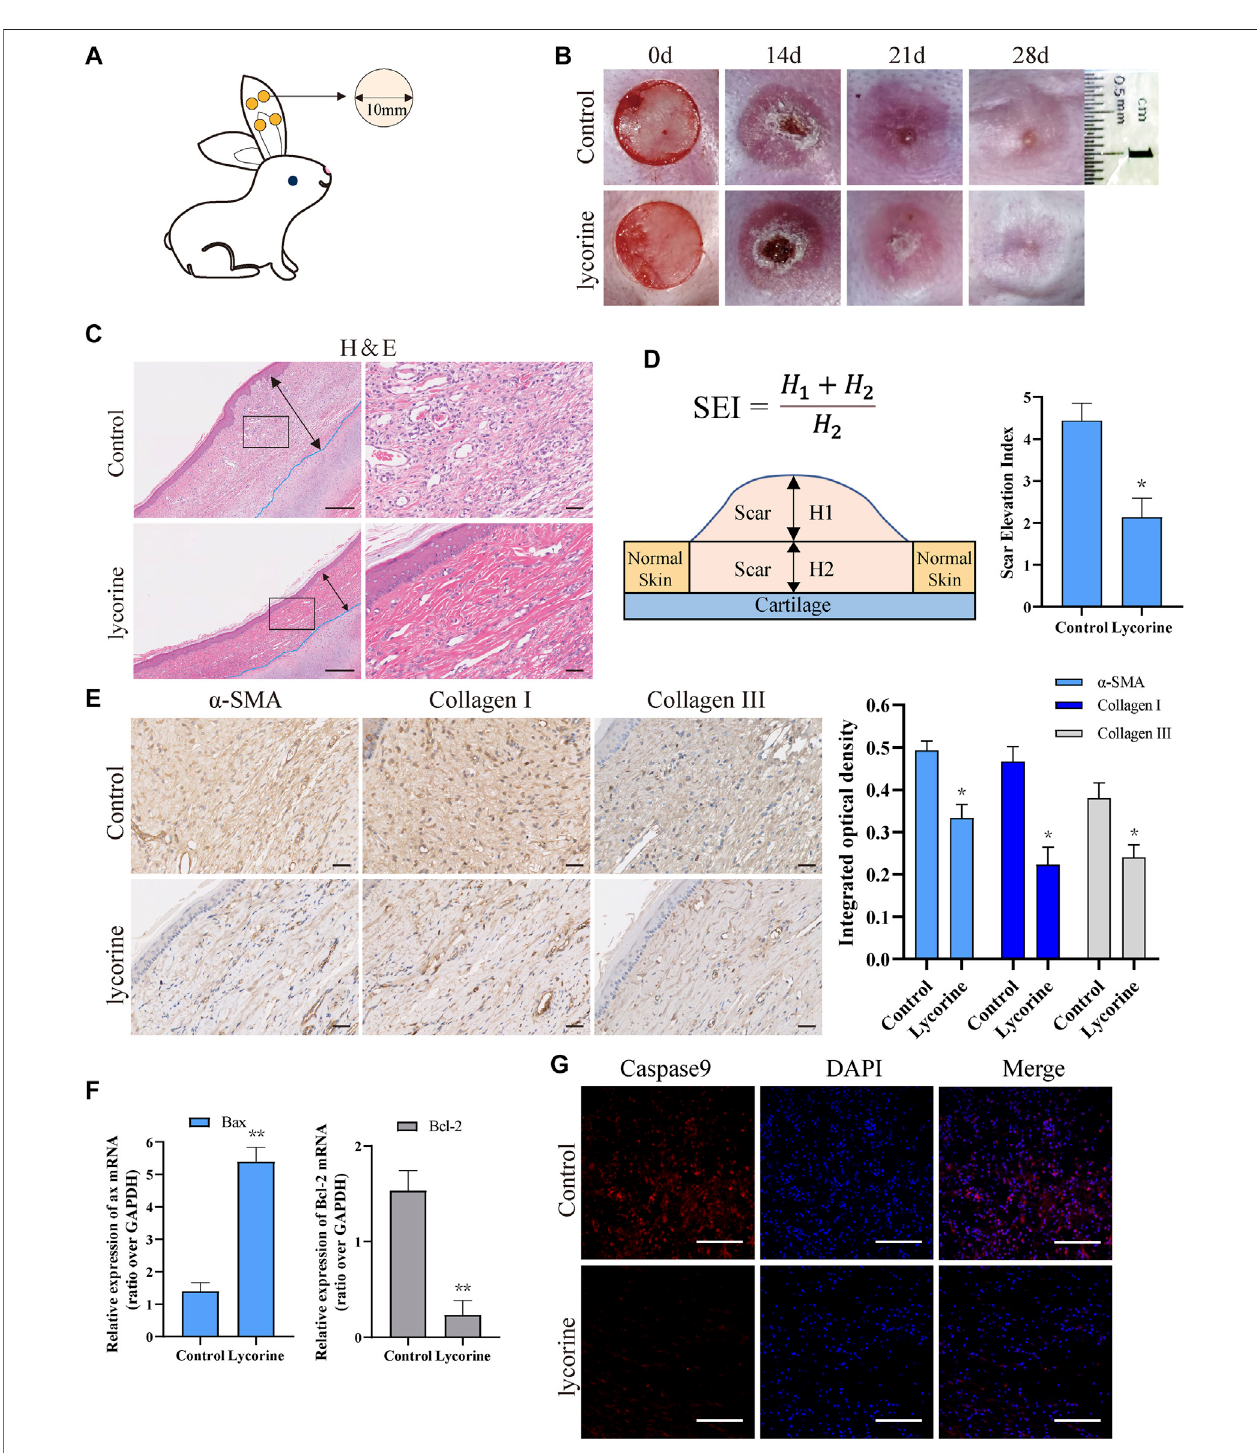
FIGURE 6 | Lycorine treatment attenuates the severity of hypertrophic scar (HS) in vivo . At 14 days post surgery in rabbit ears, the rabbits were randomized and injectedsubcutaneouslywithvehicleDMSOorlycorineintoeachrabbit ’ sear. (A) SchematicdiagramofarabbitearHSmodel. (B) Thewoundedearsandscarformation at the indicated time points. (C) HE staining of scar tissue sections at 28 days post surgery ( n = 4). “ ←→ ” indicates the scar thickness. Scale bar = 100 mm. (D) The analysisofSEIat28 dayspostsurgery.SEI > 1indicatesHS( n =4). (E) Immunohistochemistryanalysisofa-smoothmuscleactin(a-SMA),collagenIandCollagen III expression ( n = 4), Scale bar = 100 mm. (F) The relative levels of Bax and Bcl-2 mRNA transcripts in rabbit ear scar tissues at 28 days post surgery ( n = 4). (G) Immuno fl uorescence analysis ofcaspase 9 expression in rabbit ear scar tissues ( n =4). Data are mean ± standard error of the mean. * p < 0.05, ** p < 0.01, *** p < 0.001.